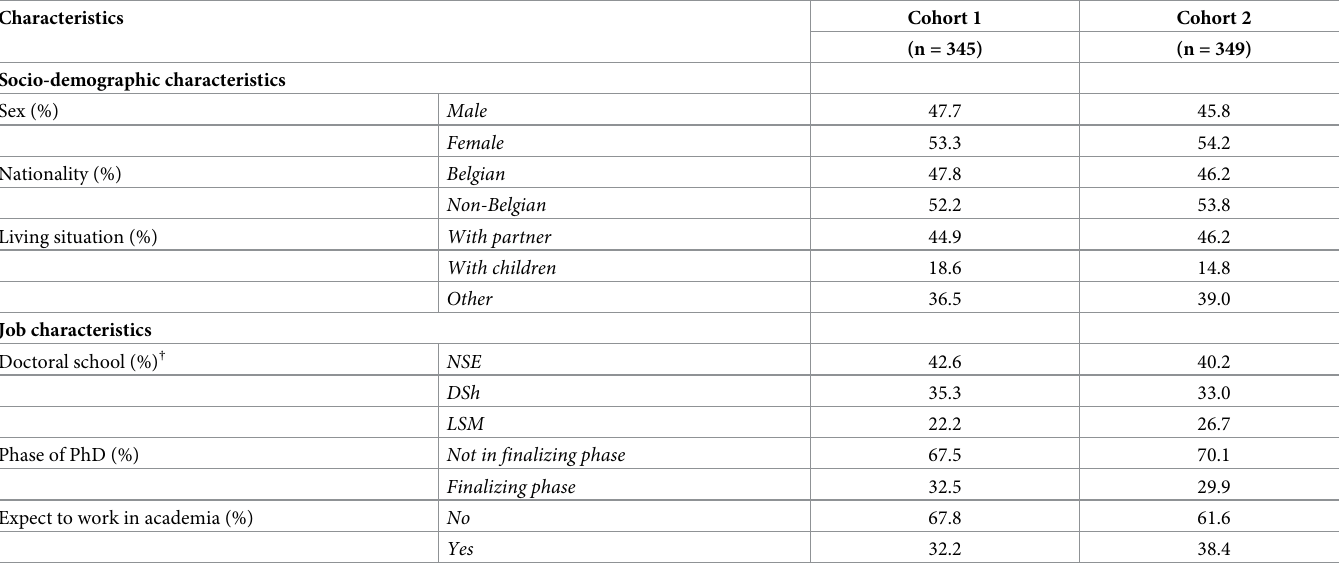
Table 2. Distribution of the socio-demographic characteristics and job characteristics by